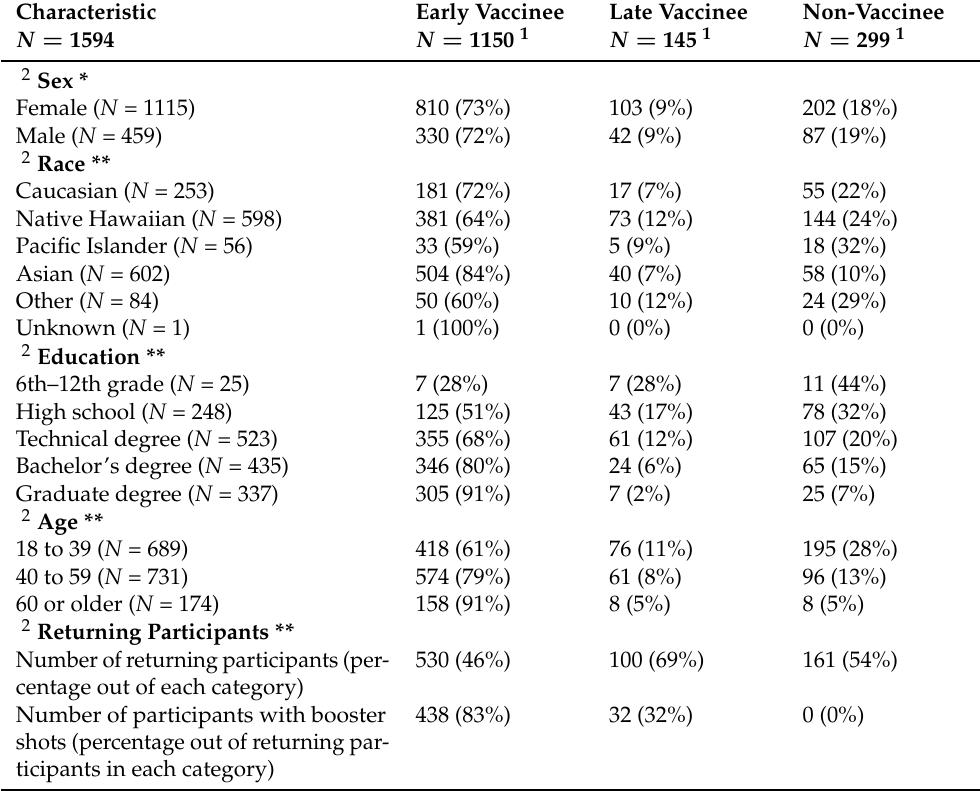
Table 1. Demographic statistics on the survey data, including descriptive statistics showing the count and percentage of participants in each vaccination stage. In addition, the numbers of returning participants in all vaccination stages are